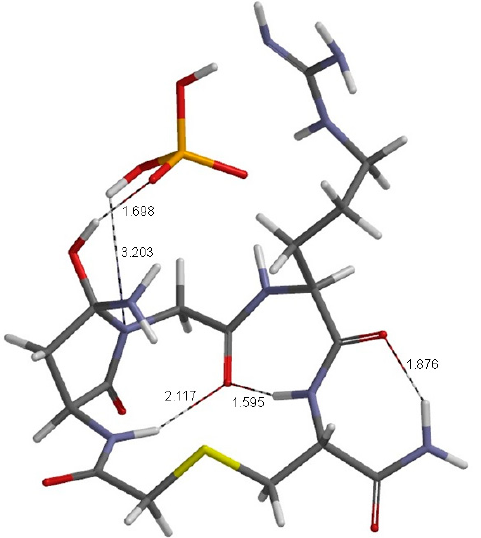
Figure 6. The geometry of TH1, the tetrahedral intermediate directly connected to TS1 (Figure 5). Selected interatomic distances are shown in Å. Grey: carbon; white: hydrogen; blue: nitrogen; red: oxygen; orange: phosphorus; yellow: sulfur.